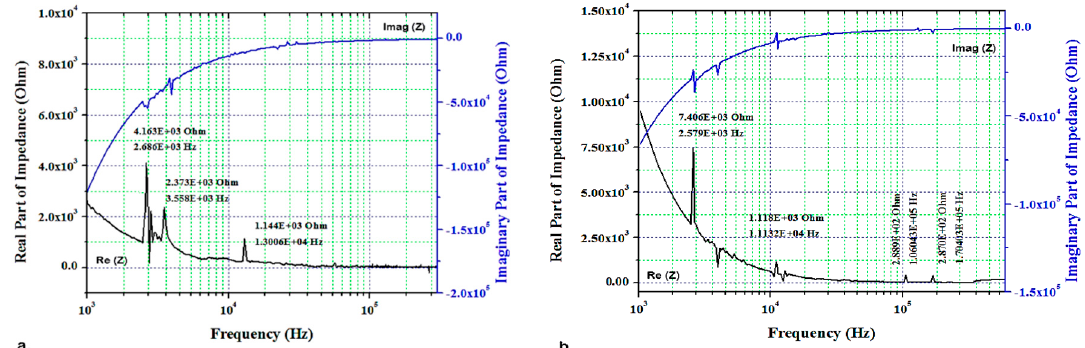
Figure 7. Real and imaginary EMI for the blade L 2 , frequency sweep at 1–600 kHz using transceiver board at 20 °C; ( a ) pristine blade and ( b ) damaged blade.